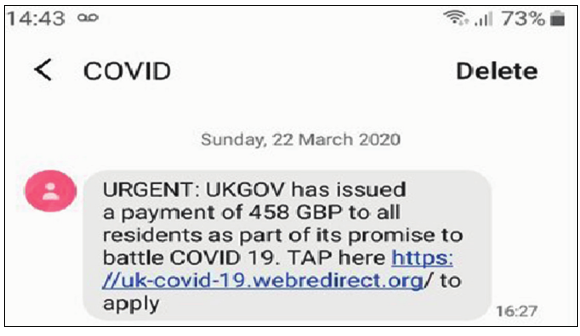
Figure 9: UK government-themed SMS phishing